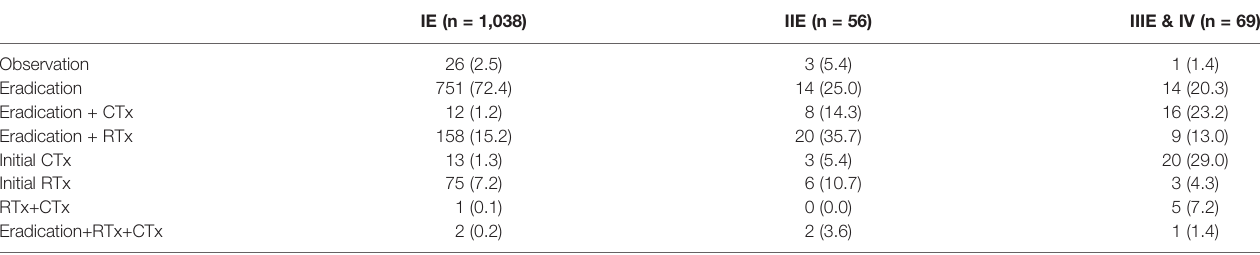
TABLE 2 | Treatment of patients with gastric MALT lymphoma according to stage.